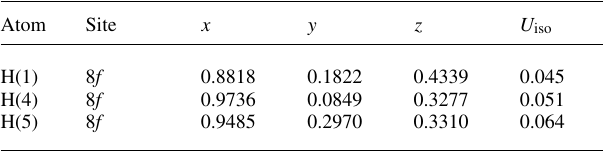
Table 2. Atomic coordinates and displacement parameters (in Å 2 )